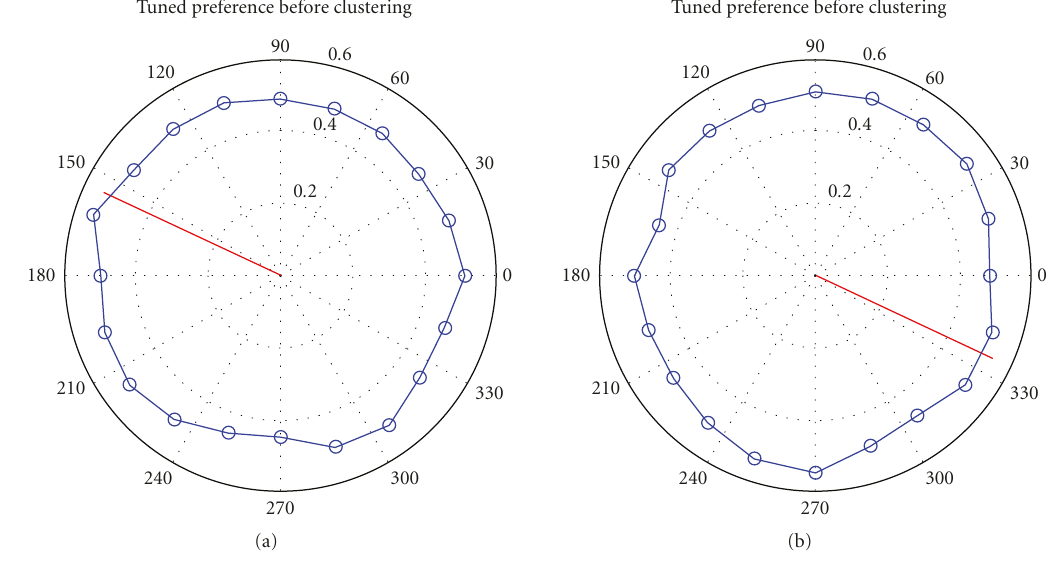
Figure 6: Tuning Preference for two classes (initialized).